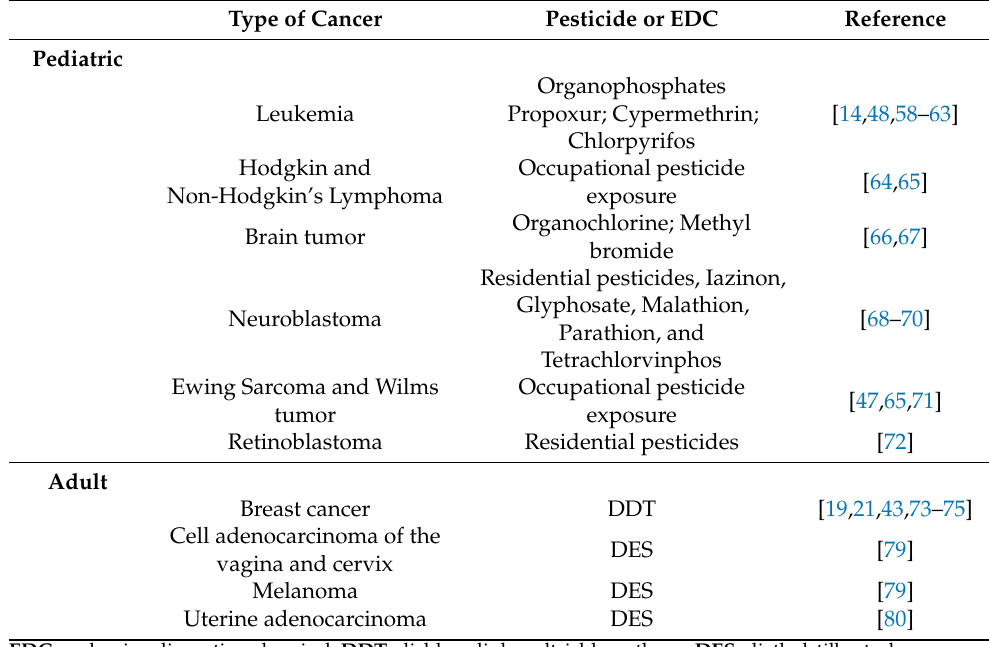
Table 1. Pediatric and adult cancers resulting from parental exposure to pesticides or endocrine disruptors. Type of Cancer Pesticide or EDC